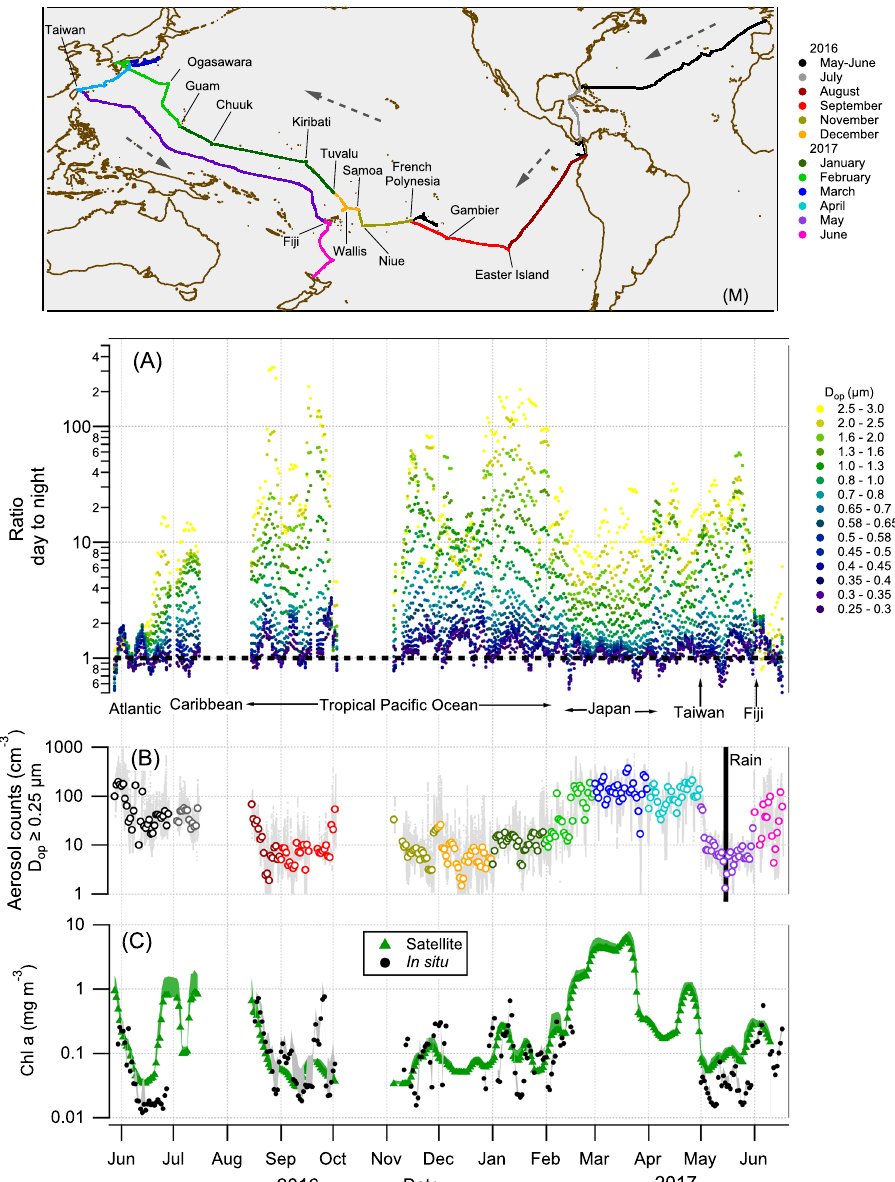
Fig. 1 Day-to-night ratios for individual bins of the optical particle counter, total marine aerosol count for optical diameter ( D op ) ≥ 0.25 μ m, and chlorophyll- a concentration along R/V Tara ’ s route. (M) Tara ’ s route, color-coded by month and dotted arrows showing the sailing direction. A The ratio (5-day running average) of day-to-night concentration of marine aerosol for each size bin of the optical particle counter. B The total aerosol count (daily mean) for D op ≥ 0.25 μ m, the gray dots are the raw total counts per minute. The colors as de fi ned in the map. C A 5-day running average of chlorophyll- a concentration measured with the AC-S aboard Tara (black circles) and calculated using satellite data (green triangles; see “ Methods ” ), with the shaded area outlining one standard deviation. The day-to-night ratios are greater than one on the vast majority of the route and largest in clean areas with low chl- a concentration, i.e., in oligotrophic ( “ blue ” )